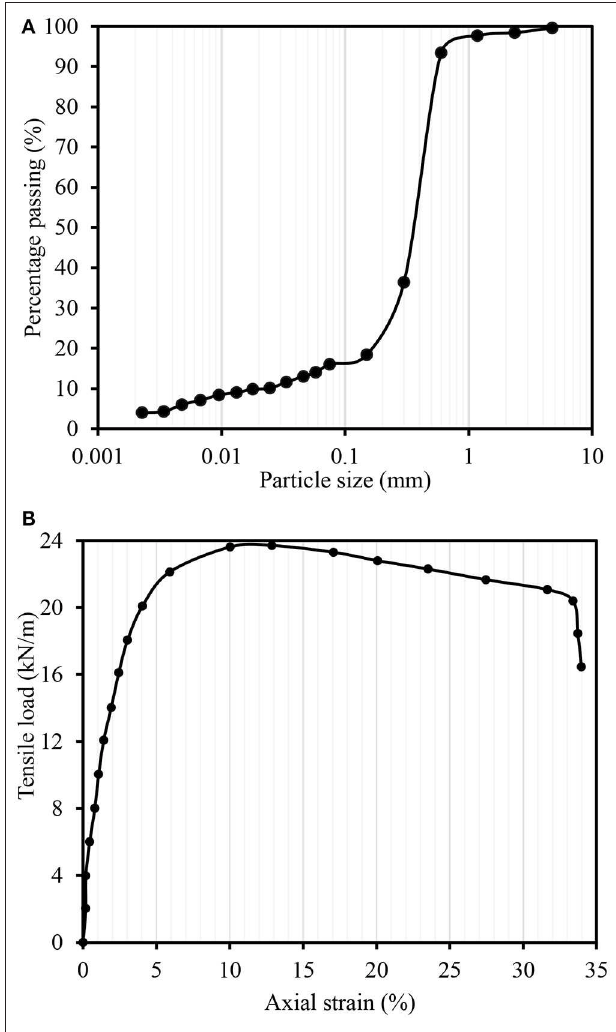
FIGURE 1 | Characterization of materials: (A) particle size distribution of subgrade soil; and (B) stress vs. strain response of geocell